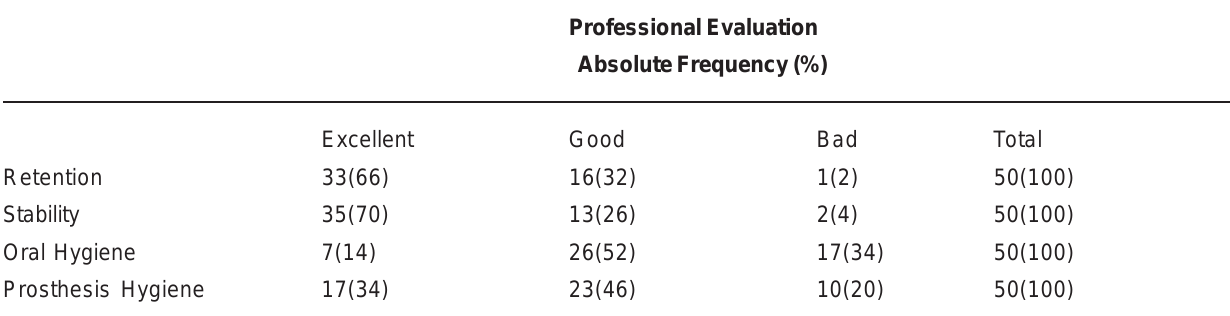
TABLE 3- Professional evaluation of retention, stability, oral and prosthesis hygiene